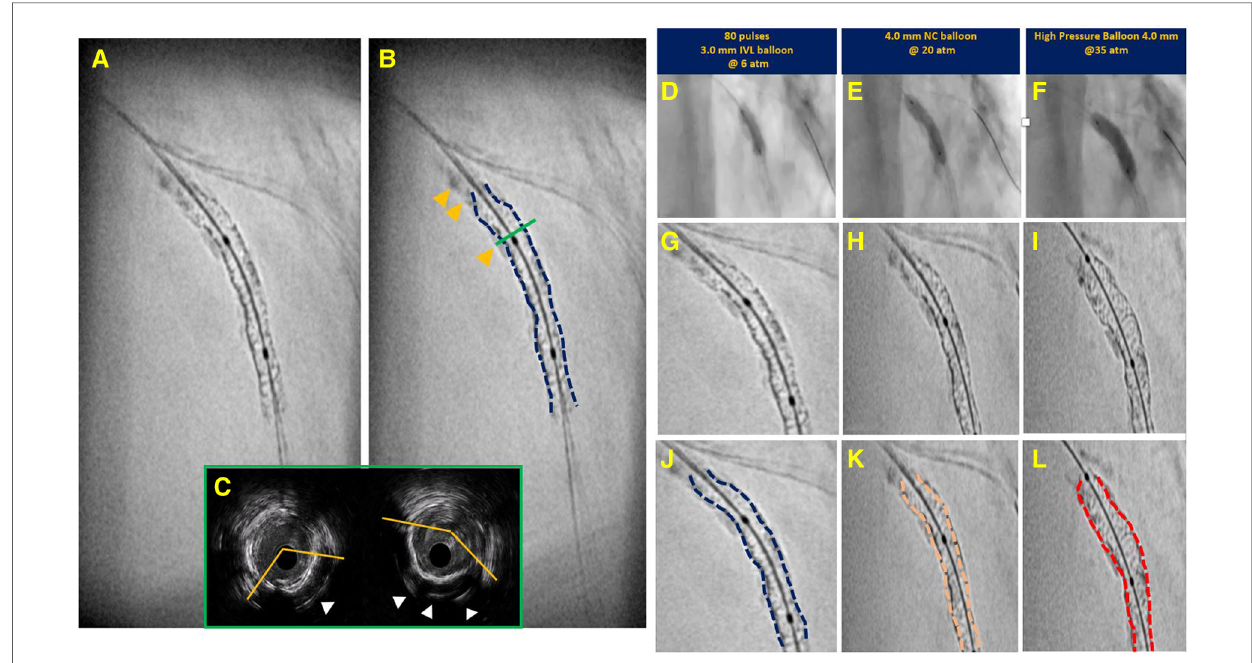
FIGURE 3 Case example of calci fi ed in stent restenosis. Enhanced angiography (Panel A ) proved helpful in de fi ning presence of signi fi cant calci fi ed component (yellow arrowhead in Panel B ) and associated stent underexpansion (dotted blue line). On Intravascular ultrasound (at the level of green line in Panel C ), calcium component appeared not circumferential and possibly thin according to evidence of reverberations (white arrowheads), even though they could have been misinterpreted for stent struts). Panels D,E show resistant calcium with underexpansion of intravascular lithotripsy (IVL) and non- compliant (NC) balloons. Eventually expansion achieved with high pressure balloon (Panel F ). Comparing enhanced angiography at each step (baseline — Panel G – J ; after lithotripsy and NC dilation in Panels H – K ; after high pressure balloon in Panels I – L ) it is possible to appreciate degree of calcium modi fi cation with increasing improvement of stent